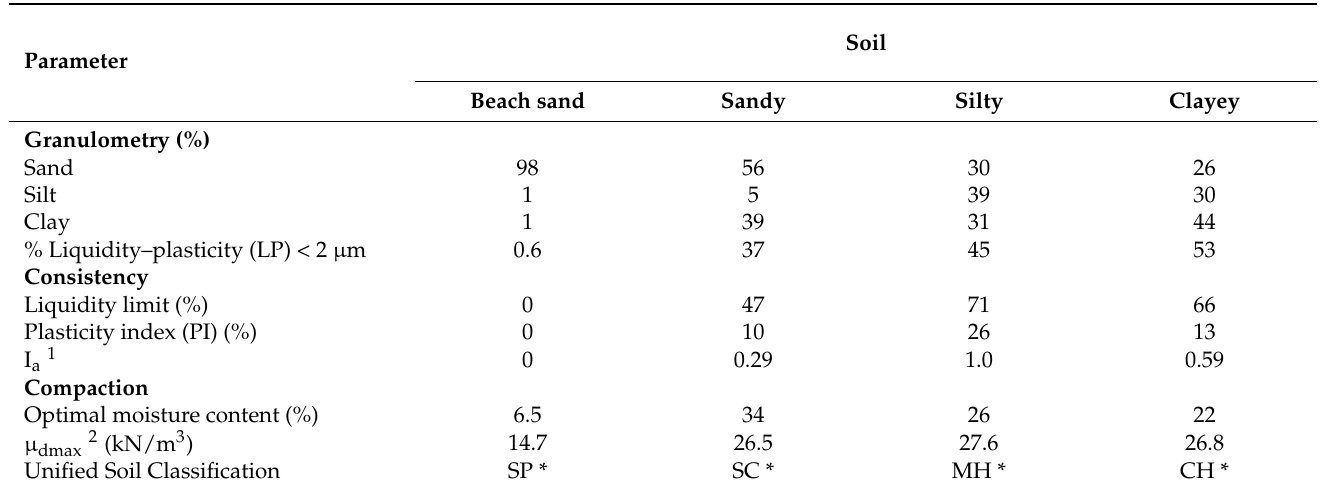
Table 6. Granulometry, consistency, compaction and soil classification